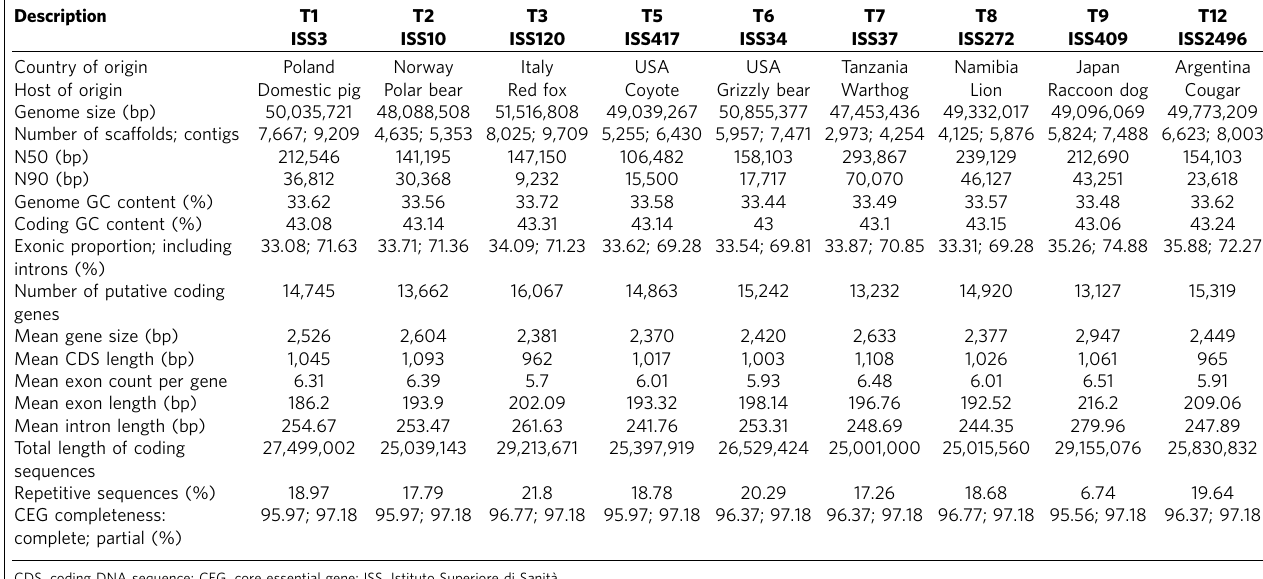
Table 1 | Assembly and gene prediction statistics for the draft genomes of all recognized encapsulated Trichinella taxa*. Description